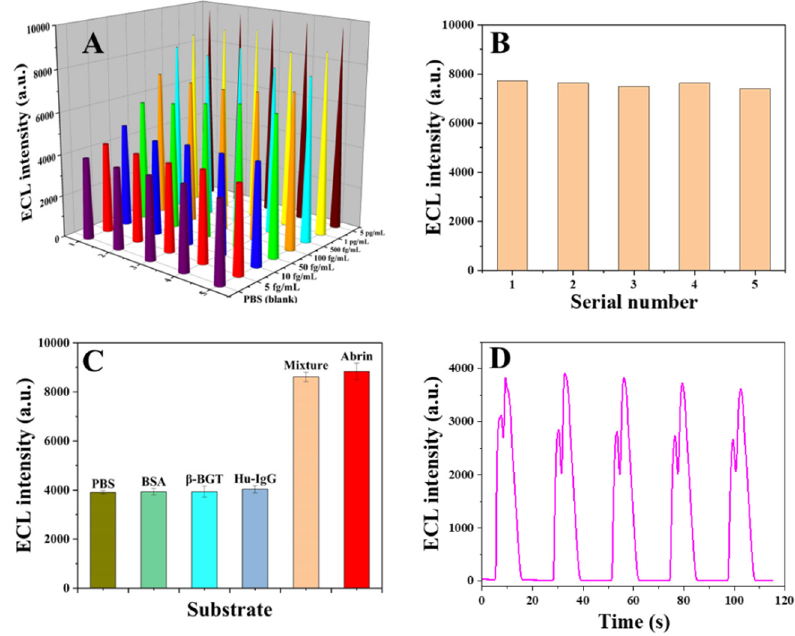
Figure 9. ( A ) Detection values for different concentration samples; ( B ) reproducibility test; ( C ) speci- ficity test; ( D ) stability test (five cycles).